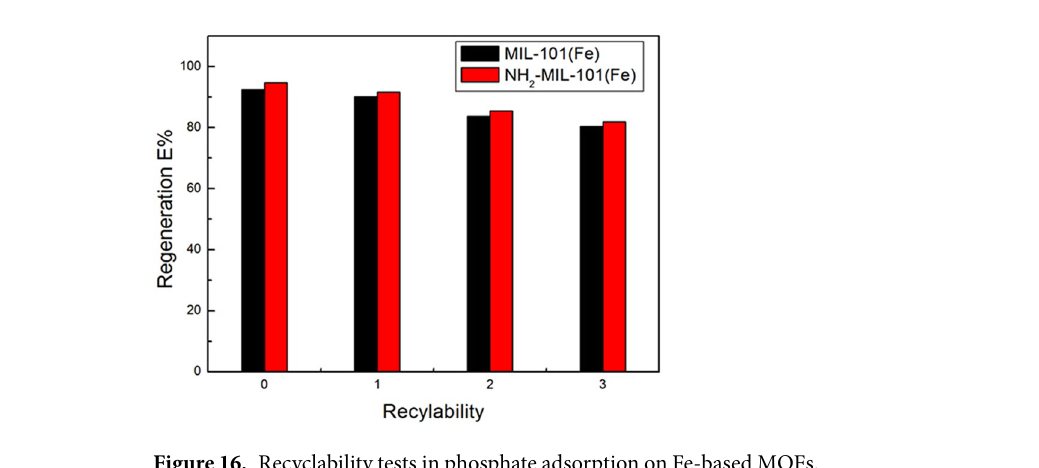
Figure 16. Recyclability tests in phosphate adsorption on Fe-based MOFs.